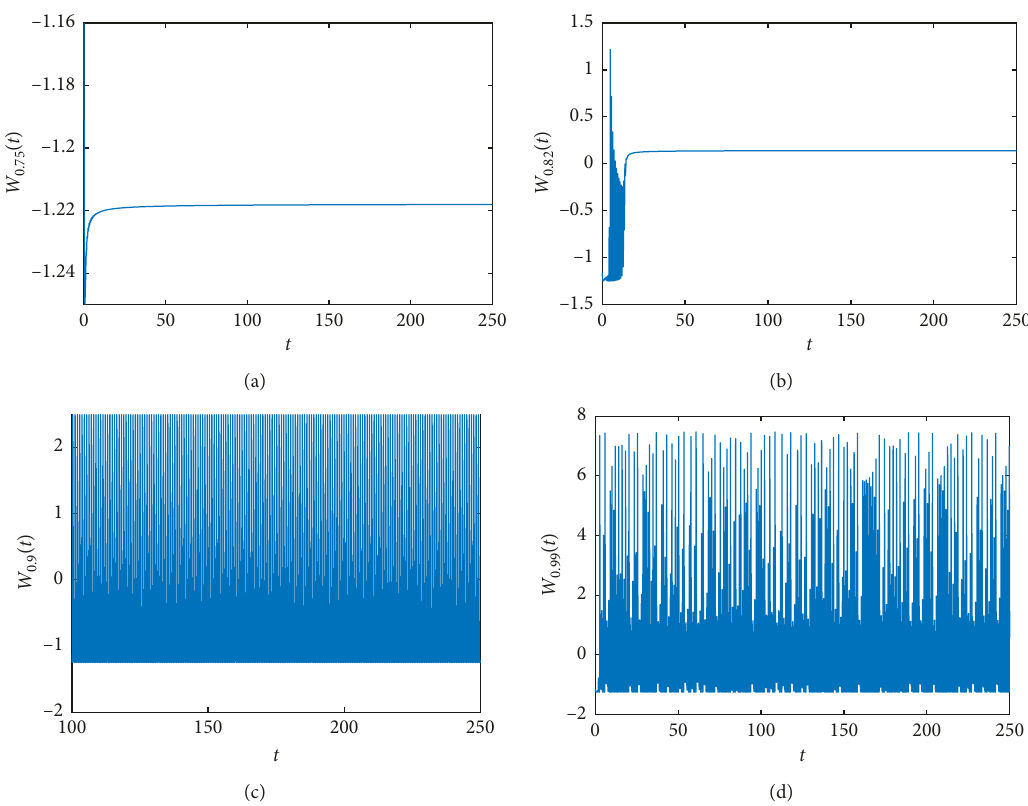
Figure 10: The memductance W (c) memductance W